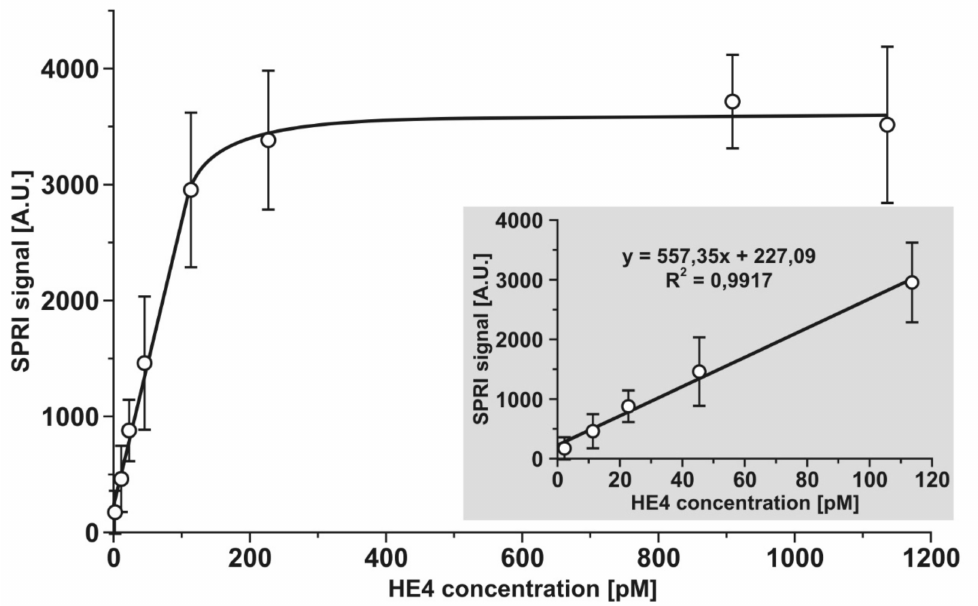
Figure 2. Dependence of the analytical signal on HE4 concentration. Calibration